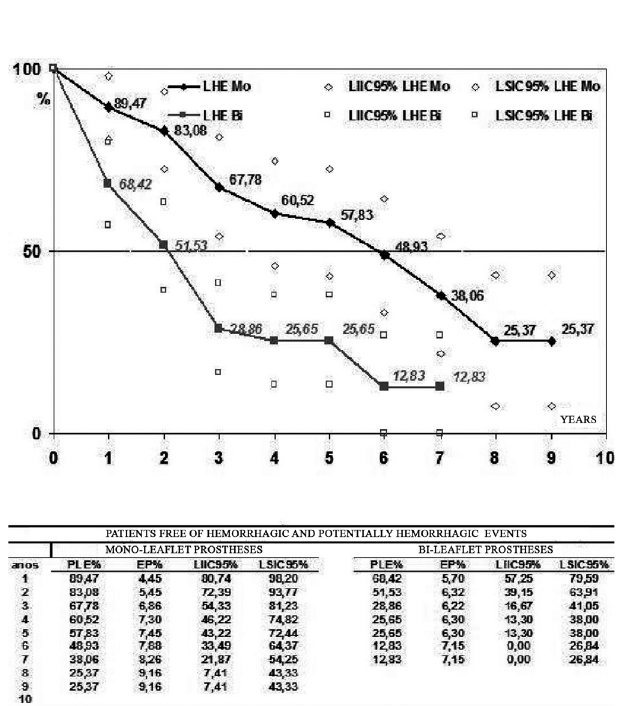
Fig. 5 - Curves and actuarial data showing the percentage of patients free of bleeding and potentially bleeding PB (ordinate) with time - years (abscissa) for both types of prostheses studied. Mo = Mono-leaflet prosthesis; Bi = Bi-leaflet prosthesis; SE = standard error range; LLCI95% = lower limit of 95% Confidence Interval and ULCI95 % = Upper Limit of 95% Confidence